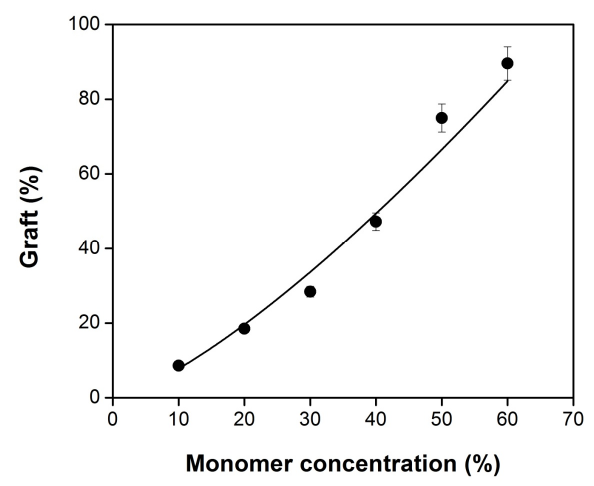
Figure 1. Grafting yield by one step method of poly(N-vinylcaprolactam) (PNVCL) and poly-(N-vinylimidazole) (PNVIM) onto silicone rubber (SR) films as function of monomer concentration in toluene, dose fixed of 50 kGy and dose rate of 9.3 kGy h − 1 .